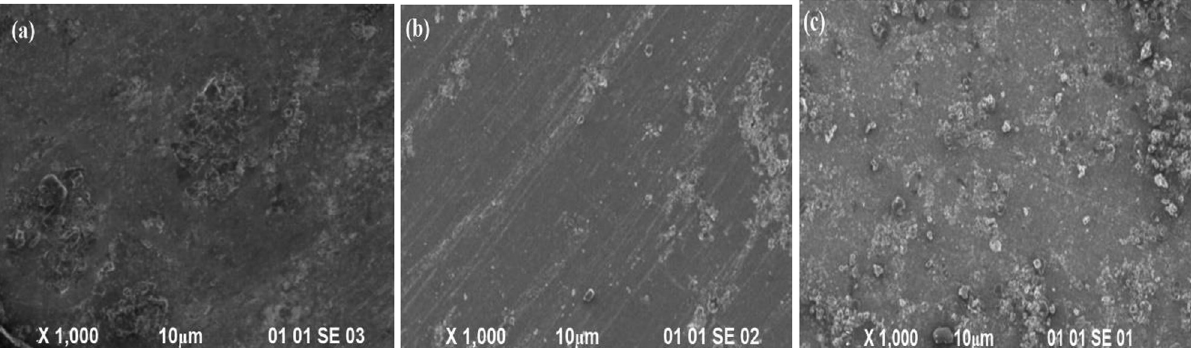
Figure 13: SEM images of welded sample: ( a ) FSW 1 , ( b ) FSW 6 , and ( c ) FSW 9 after corrosion